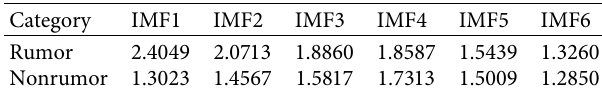
Table 3: Average correlation dimensions of the principal components.